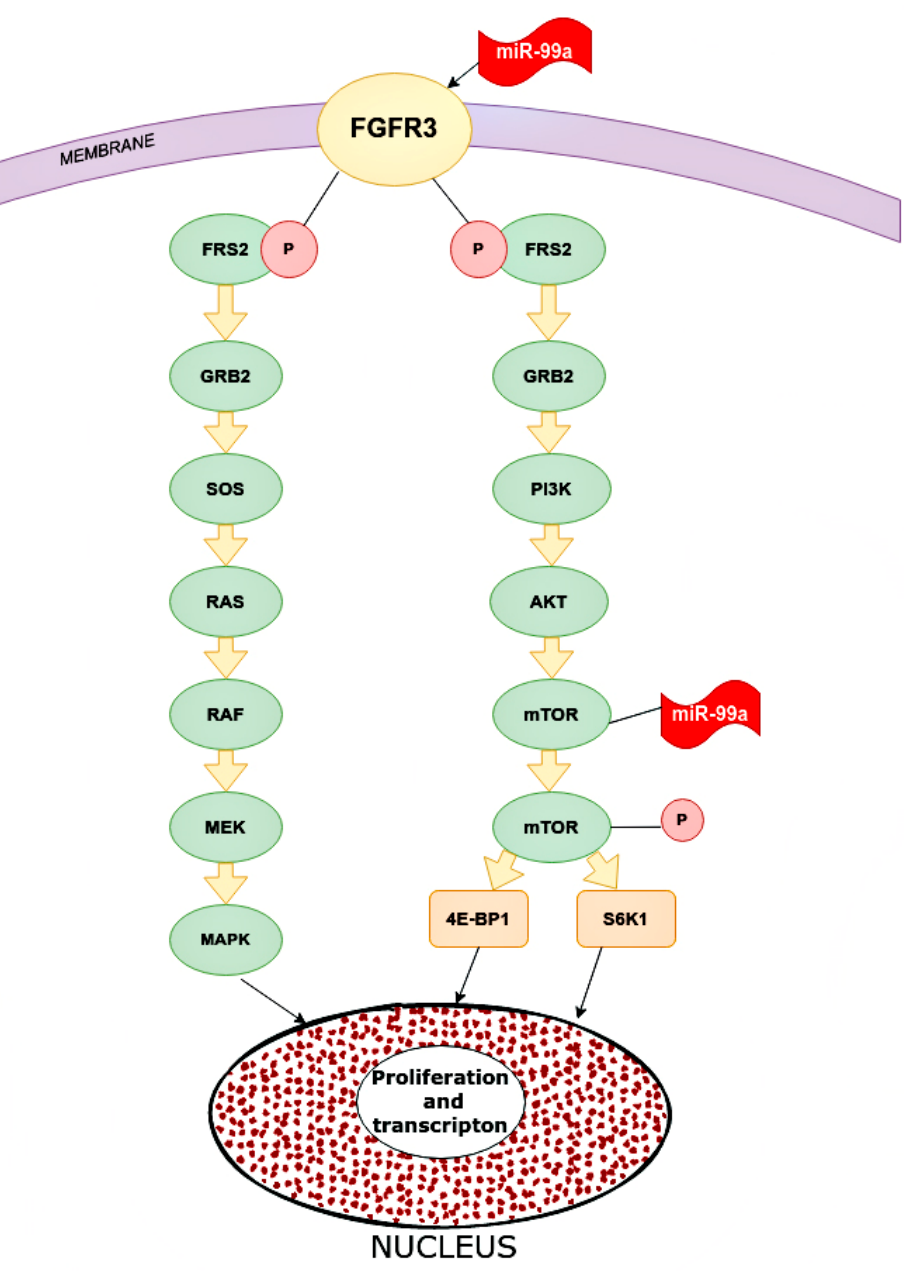
Figure 6. Main pathways in which miR-99a inhibits in cancer cells. microRNA-99a inhibits FGFR3 on the cancer cells. Inhibited FGFR3 cannot activate downstream cascade pathways: PI3K/AKT and RAS/RAF/MEK/MAPK. For the PI3K/AKT signaling pathway, FGFR3 phosphate FRS2 inhibits GRB2. This inhibited molecular PI3K, which inhibits mTOR and as a result, reduces proliferation and transcription in the nucleus. As for the RAS/RAF/MEK/MAPK pathway, inhibited GRB2 inactivate SOS, RAS, RAF, MEK, and MAPK, and eventually increase proliferation and transcrip- tion. FGFR2 (CD332)—fibroblast growth factor receptor 2, FRS2—fibroblast growth factor recep- tor substrate 2, GRB2—growth factor receptor-bound protein 2, PI3K—phosphoinositide 3-kinase, AKT—RAC-alpha serine/threonine-protein kinase, protein kinase B alpha, RAS—rat sarcoma virus kinase, RAF (rapidly accelerated fibrosarcoma)—proto-oncogene serine/threonine-protein kinase, mTOR—mammalian target of rapamycin kinase, MEK (MAP2K, MAPKK)—mitogen-activated pro- tein kinase, MAPK—mitogen-activated protein kinase, 4E-BP1—eukaryotic translation initiation factor 4E-binding protein 1, S6K1—ribosomal protein S6 kinase